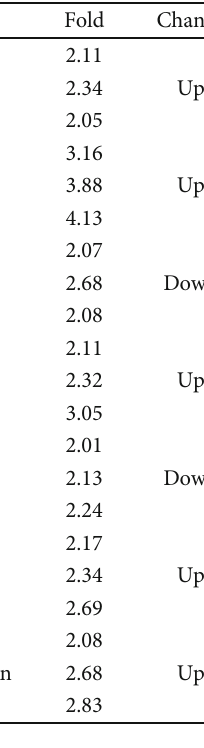
Table 3: DSs regulate the expression of in fl ammation-related genes.